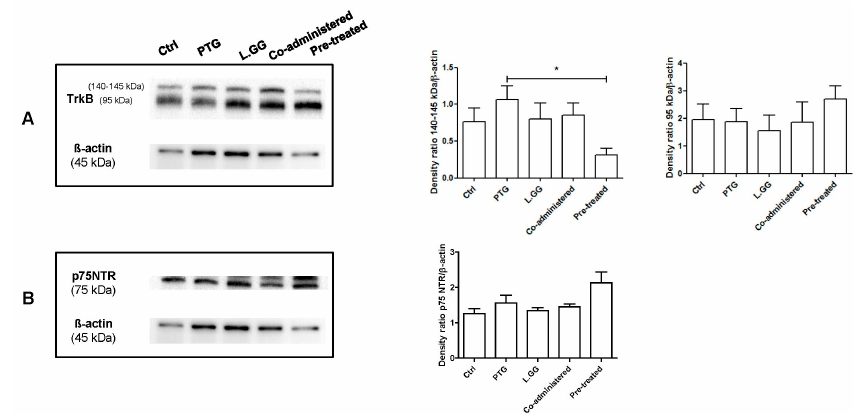
Figure 5. Western blot analysis of TrkB ( A ) and p75NTR ( B ) in brain samples from control and treated rats, each group consisting of six rats. Immunoreactive bands were quantified using Image Lab Software (BioRad Laboratories Inc., Hercules, CA, USA). The graphs on the right show quantification of the intensity of bands calibrated to the intensity of the ß-actin band. All data represent the results of at least three independent experiments (mean plus SEM). * p < 0.05. The data were analyzed by Kruskal–Wallis analysis of variance and Dunn’s Multiple Comparison Test.